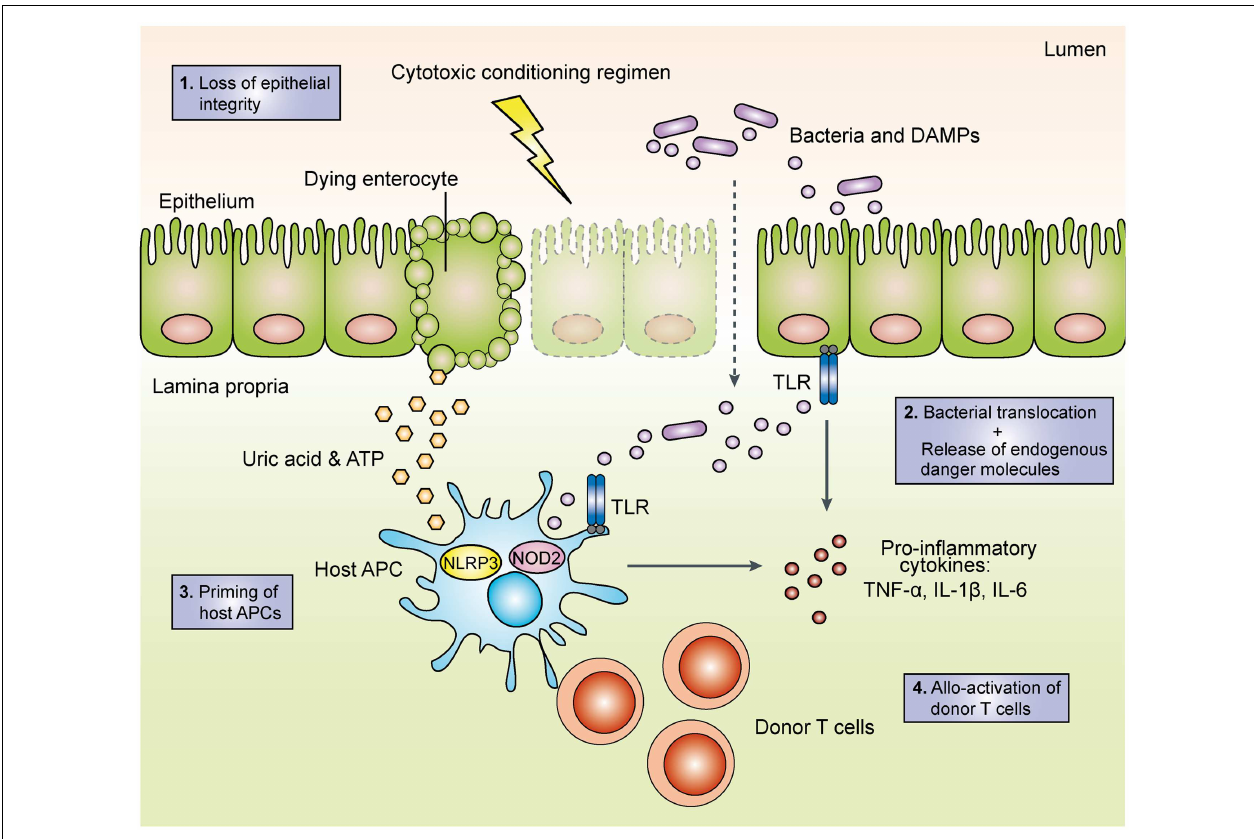
production of pro-inflammatory cytokines. Activated host and/or donor antigen-presenting cells then prime allo-reactive donorT cells, which perpetuate acute GVHD.TLR, toll-like receptor; APC, antigen-presenting cell; DAMP, danger-associated molecular pattern;TNF, tumor necrocis factor; IL, interleukin; NOD2, nucleotide-binding oligomerization domain; NLRP3, NACHT, LRR, and PYD domains-containing protein